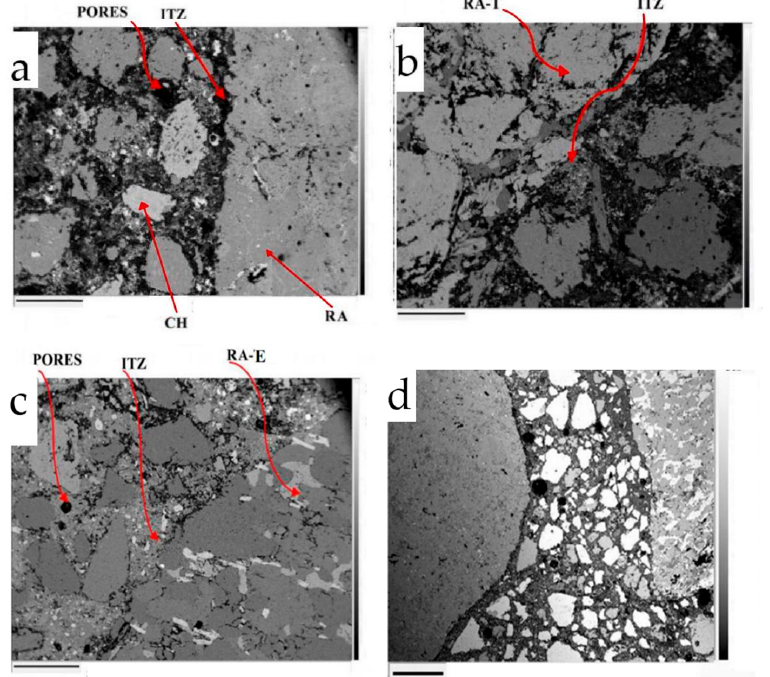
Figure 11. Micro-analysis of SRAC [112]. (( a ) Traditional method to prepare SRAC. ( b )